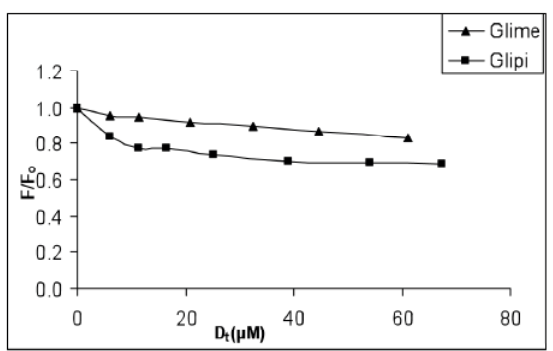
Figure 6. Relative fluorescence intensity of ANS in HSA-ANS complex as a function of drug concentration